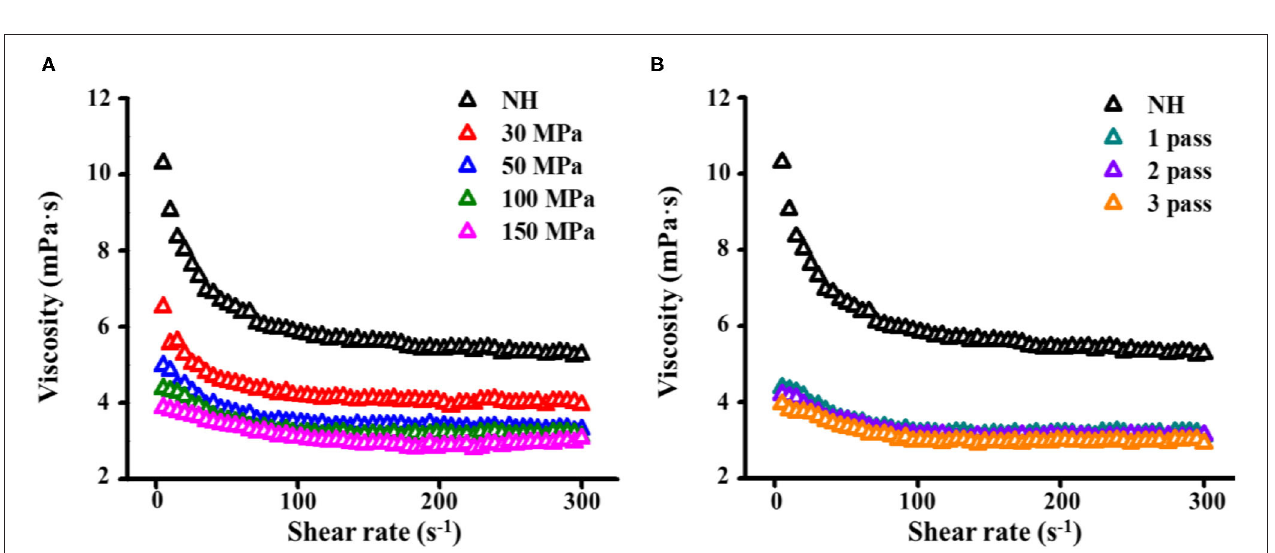
FIGURE 5 | Effect of HPH treatments on viscosity curves of NFC orange juice. (A) Homogenization pressure; (B) Homogenization